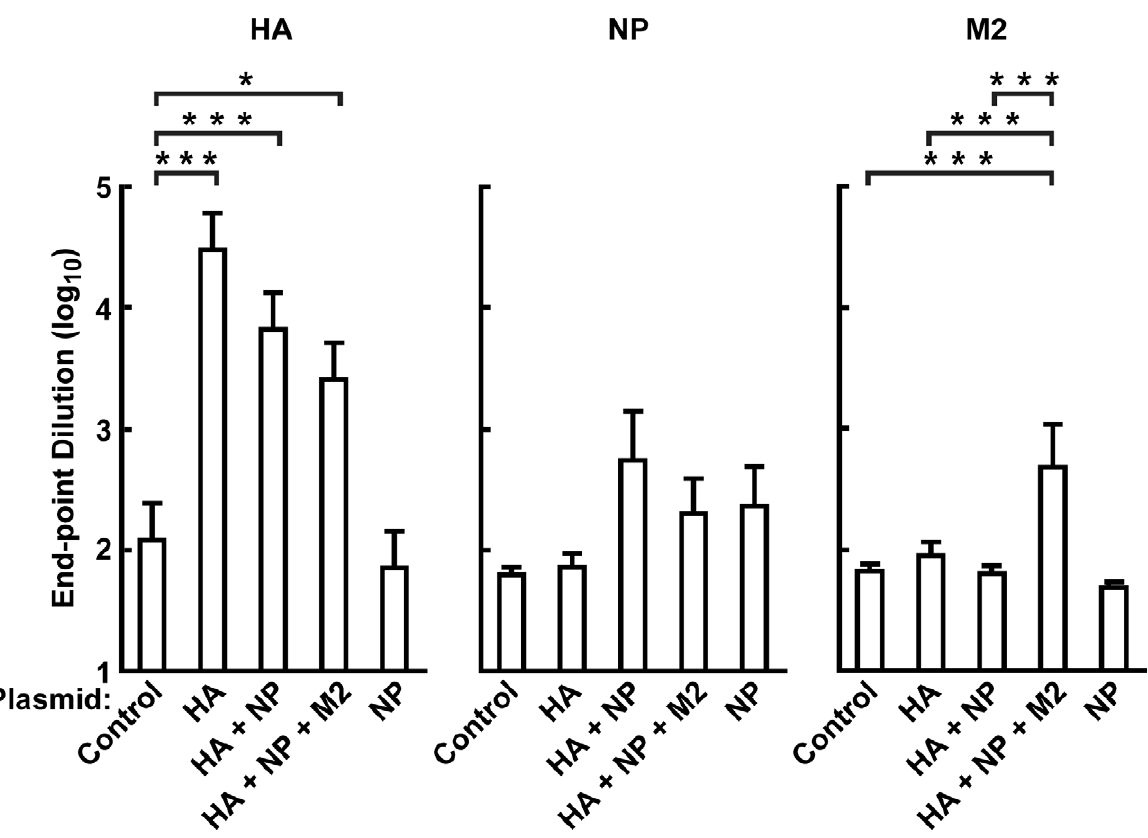
Figure 2. Detection of humoral immune responses to HA, NP and M2 by ELISA after DNA vaccination in mice. Sera from individual mice immunized with HA, HA + NP, HA + NP + M2, NP and vector control were collected 10 days after the third DNA immunization. The sera were subjected to ELISA assay to determine their end-point titers against HA(KAN-1), NP(PR8), and M2 (KAN-1). Each bar represents the group mean ( n =5 for NP, control; n =10 for HA, HA + NP, HA + NP + M2) for the end-point titers of the total IgG and IgM against HA(KAN-1) purified protein (HA), against NP(PR/8) purified protein (NP), and against M2(KAN-1) extracellular domain peptide (M2), as indicated. Each immunized group was compared to controls as well as other groups containing relevant immunogens. ANOVA tests were significant for the responses against HA and M2, but not against NP. For HA and M2, significant pairs of groups are noted on the graph. Only p -values less than 0.05/6=0.0083 (Bonferroni Correction) were considered significant for these pairwise comparisons. A single asterisk (*) represents a p -value between 0.008 and 0.001, while ** indicates , 0.001, and *** indicates , 0.0001. All HA-containing groups showed significant antibody responses against HA compared to controls ( p , 0.0013), but did not differ significantly among themselves. Differences between NP-immunized groups were at the border of statistical significance by ANOVA ( p =0.0504), as was the comparison between HA + NP and HA groups ( p =0.008) when adjusted for multiple comparisons. The only M2-containing group, HA + NP + M2, elicited a significant humoral response against M2 protein compared to control ( p ,